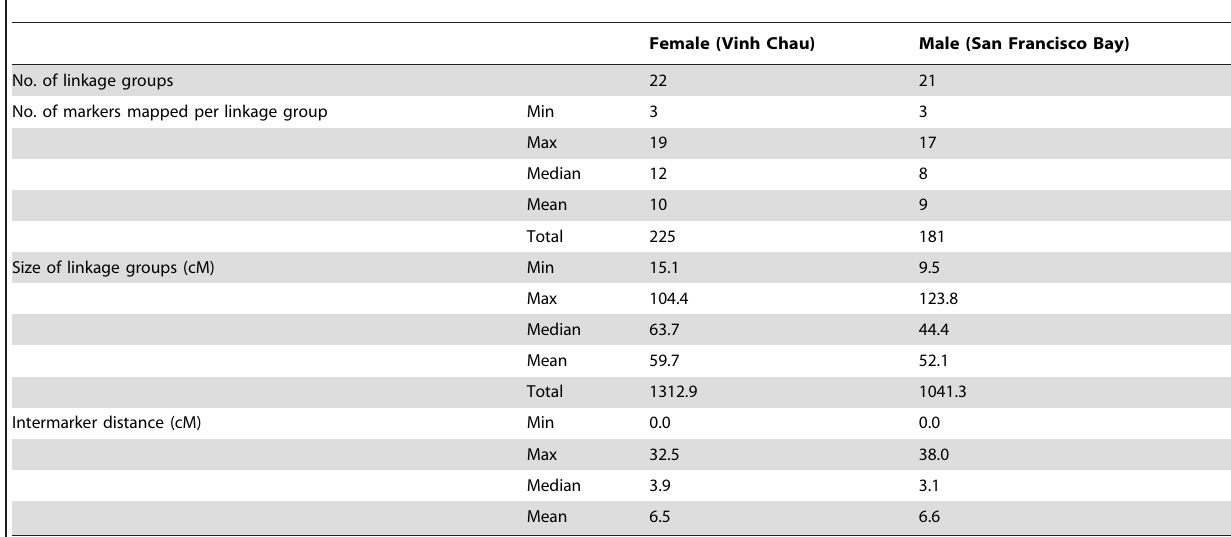
Table 1. Statistics for the female and male linkage